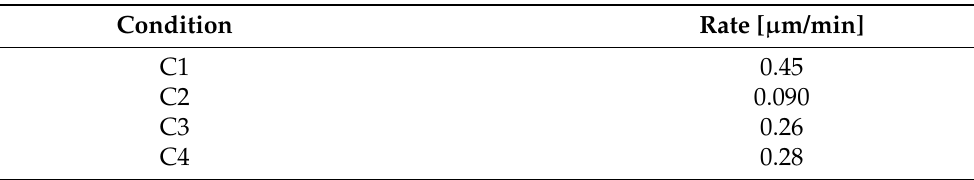
Table 2. Average etch rates for the investigated MACE conditions.